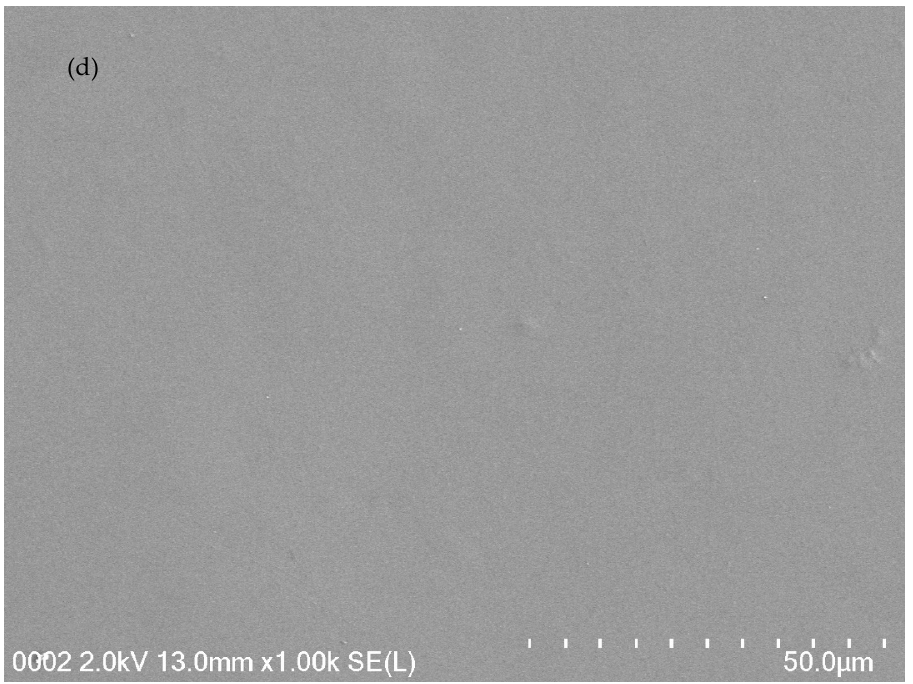
Figure 4. FESEM images for ( a ) CSDPB1, ( b ) CSDPB2, ( c ) CSDPB3, and ( d ) CSDPB4 blend electrolytes.